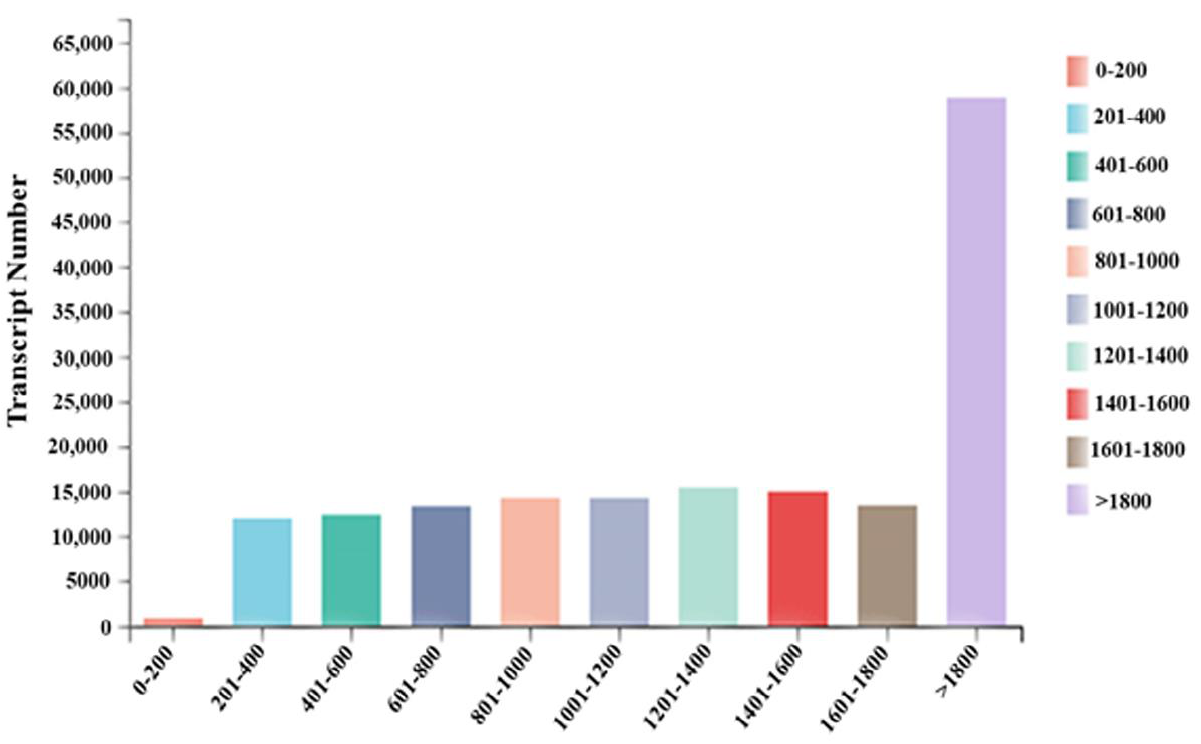
Figure 2. The length distribution of reads of transcripts length. The length and distribution of reads aligning to the reference genome Triticum _ aestivum, version: iwgsc_refseqv1.0 source, from selected 0 – 200 (brown), 201 – 400 (Cyan), 401 – 600 (Aqua), 601 – 800 (Cadet blue), 801 – 1000 (Light salmon), 1001 – 1200 (Light steel blue), 1201 – 1400 (Aquamarine), etc.